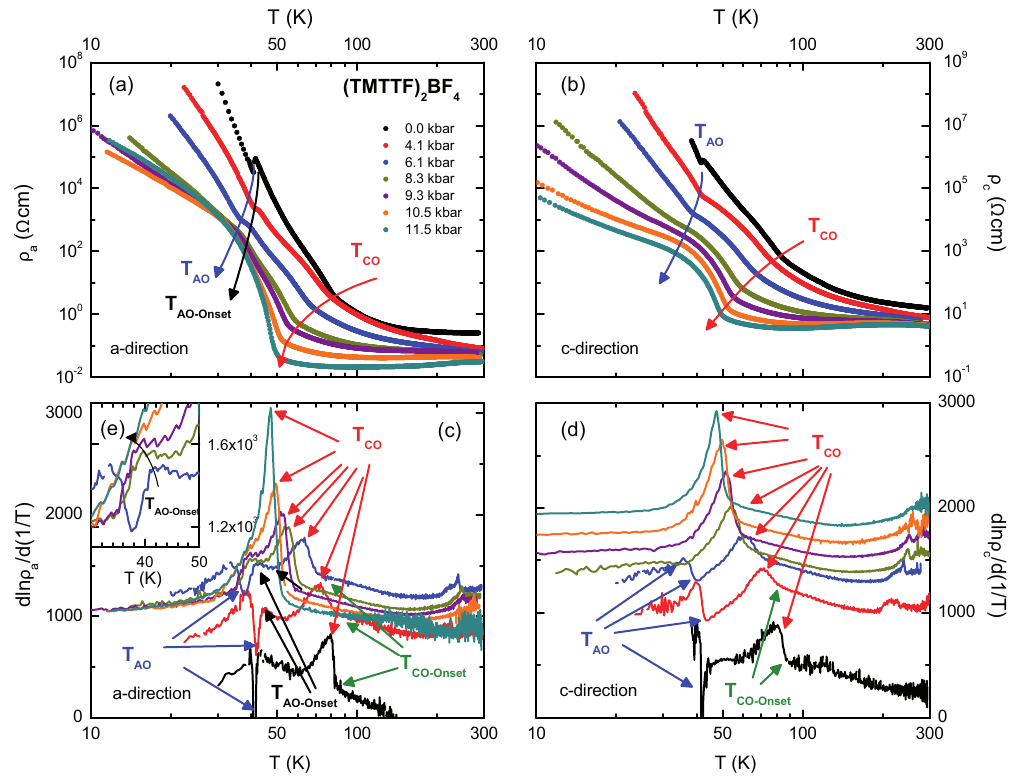
Figure 12. Temperature dependence of the dc resistivity of (TMTTF) 2 BF 4 measured for the directions ( a ) parallel and ( b ) perpendicular to the stacks when increasing hydrostatic pressure is applied as indicated. Besides the minimum in resistivity at T ρ , the charge-order transition at T CO and the anion ordering at T AO is clearly observed. The analysis of the data is illustrated in panels ( c ) and ( d ) where the temperature derivative dln { ρ a } /d ( 1/ T ) is plotted for both orientations. The extrema indicate the ordering temperatures T AO and T CO . In addition we define an onset temperature for the charge and anion orders. The inset ( e ) enlarges the range around the AO